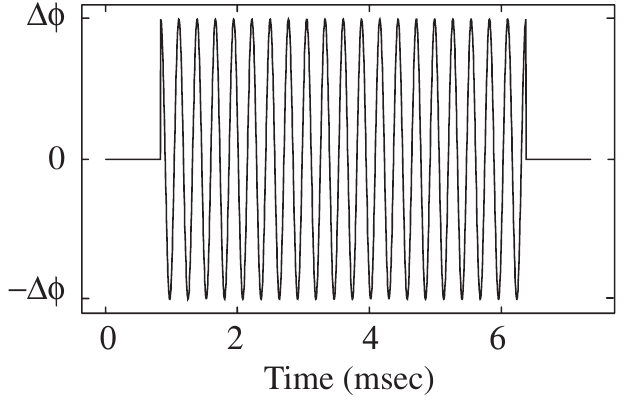
FIG. 4. Typical phase-modulation waveform used for tracking.